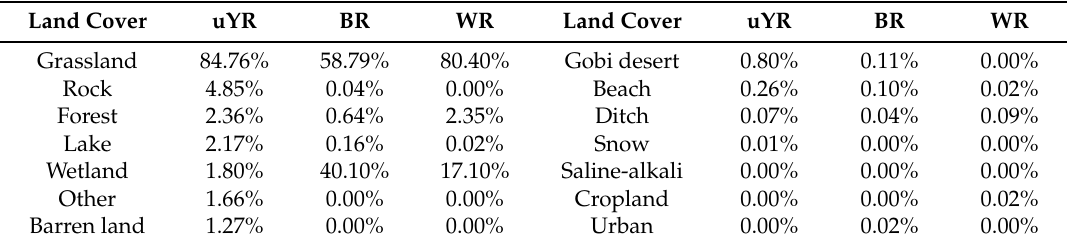
Table 4. Reference land cover characteristics in the uYR, BR and WR basins in 1985 derived from the satellite-based Land-use and Land cover Dataset of China [32].